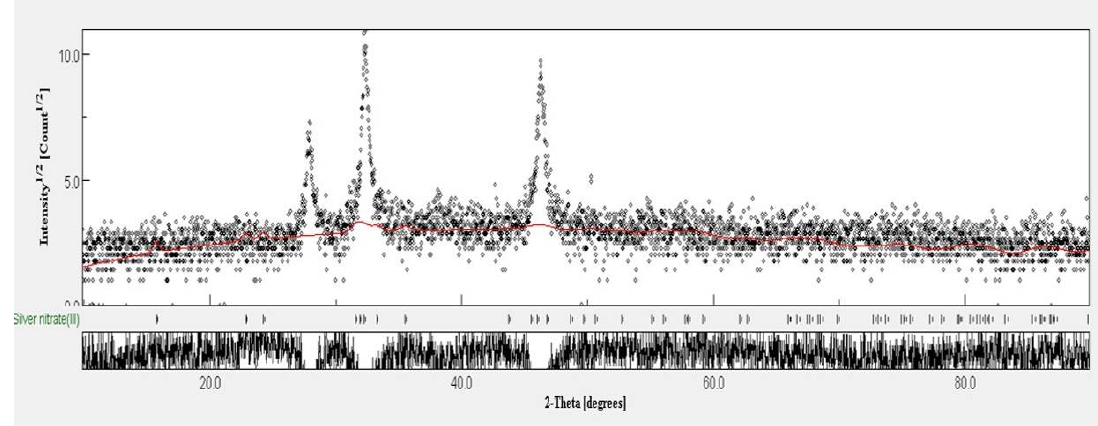
Figure 6. Rietveld method analysis of the XRD data of silver nanoparticles derived from marine Streptomyces sp. Al-Dhabi-87.